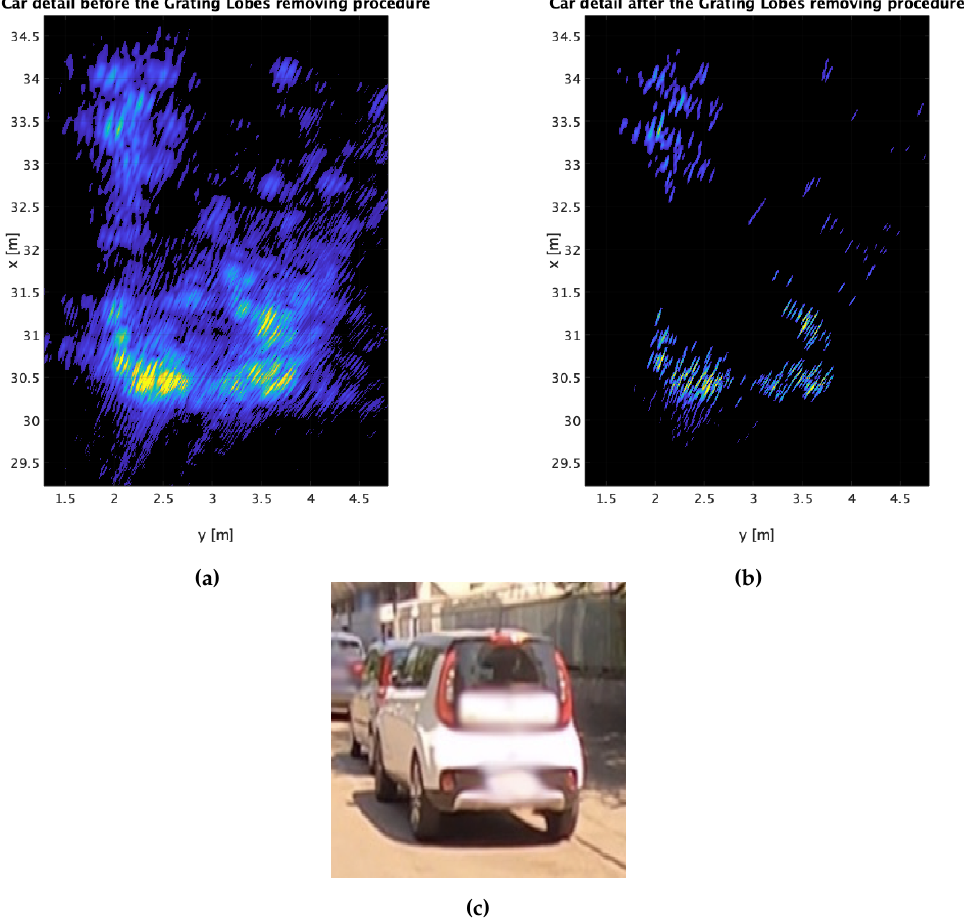
Figure 11. (a): SAR image of a car detail before the grating lobes suppressing algorithm. (b): SAR Figure 11. ( a ): SAR image of a car detail before the grating lobes suppressing algorithm. ( b ): SAR image of a car detail after the grating lobes suppressing procedure. (c): Optical reference of the car image of a car detail after the grating lobes suppressing procedure. ( c ): Optical reference of the detail. car